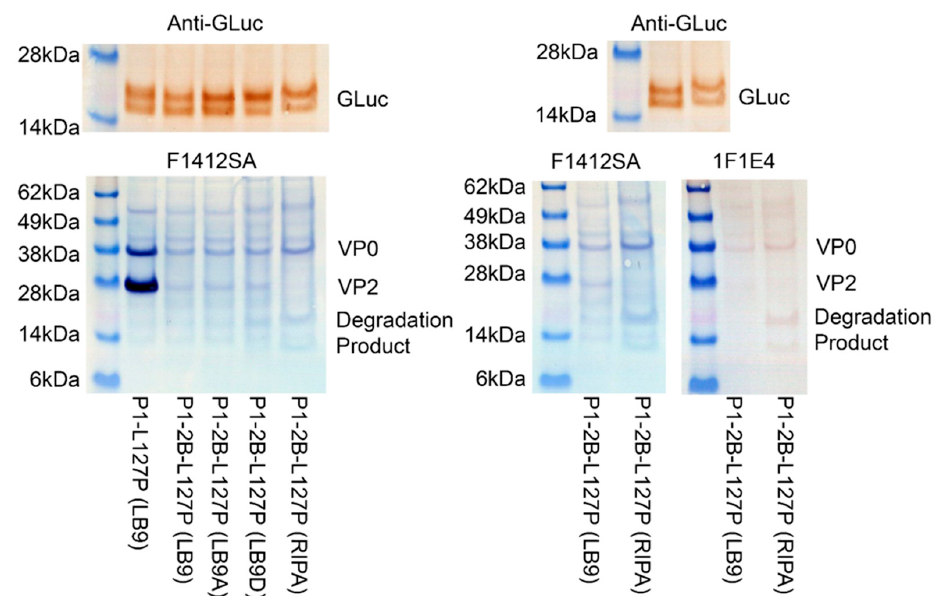
Figure 6. Utilization of alternative lysis buffers did not counter the adverse effect of 2B expression on antigen extraction. Detection with two different VP0/VP2 antibodies, F1412SA and 1F1E4, also demonstrated the presence of low-molecular-weight products, possibly indicative of VP0/VP2 degradation in 2B-expressing cells.